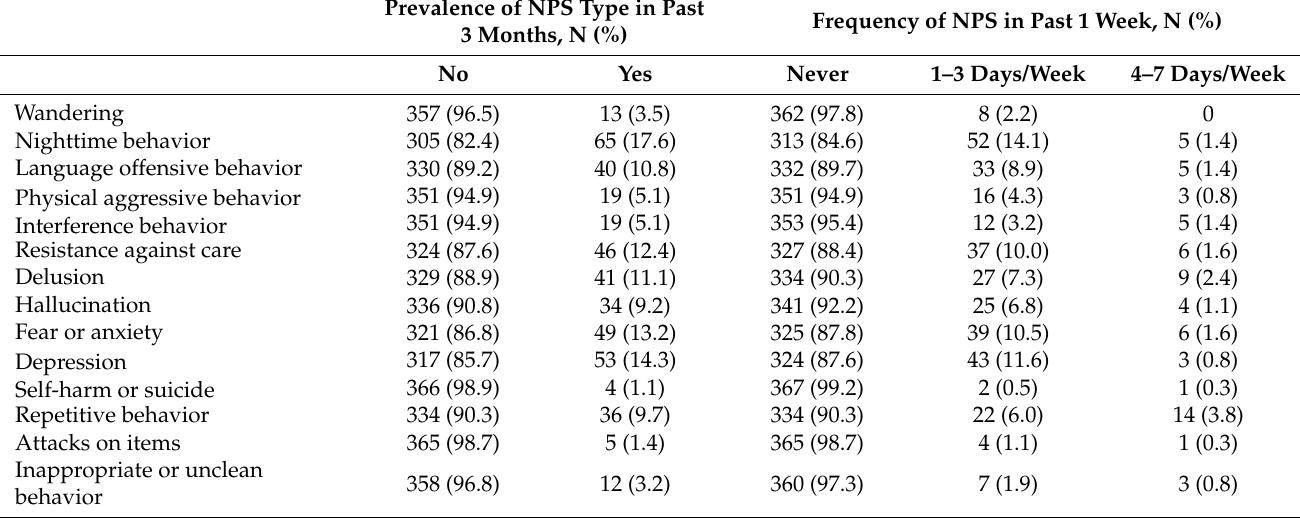
Table 2. Prevalence and frequency of each NPS type in all PD